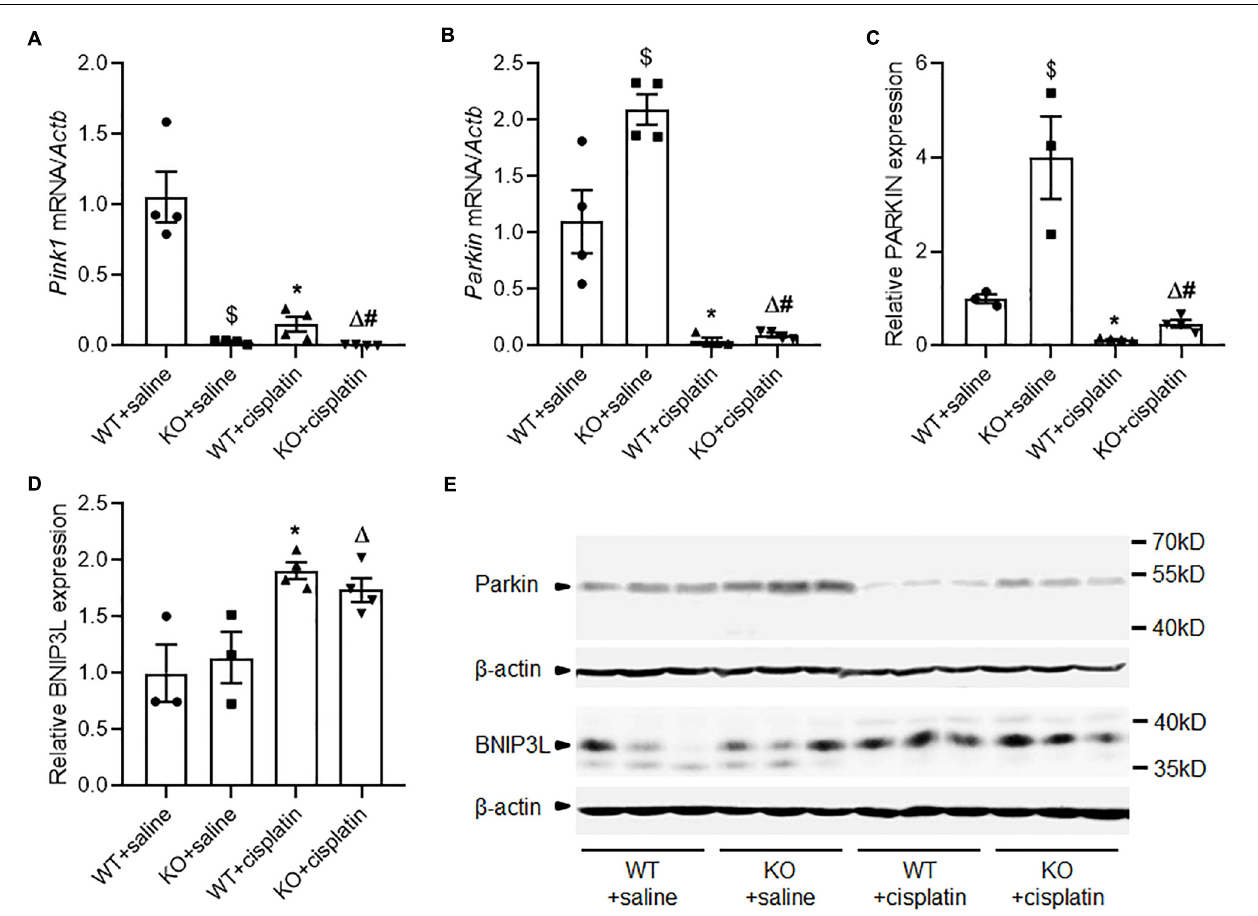
FIGURE 3 | Altered expression of PINK1, Parkin and BNIP3L during cisplatin treatment in PINK1 WT and KO rats. (A) Real-time quantitative PCR analysis of Pink1 mRNA expression in renal cortex. (B) Real-time quantitative PCR analysis of Parkin mRNA expression in renal cortex. (C) Quantitative analysis of the western blotting of Parkin. (D) Quantitative analysis of the western blotting of BNIP3L. (E) Representative western blot bands of Parkin and BNIP3L in renal cortex. N = 3 in WT + saline group and KO + saline group, N = 4 in WT + cisplatin group and KO + cisplatin group. ∗ P < 0.05, WT + cisplatin vs. WT + saline; # P < 0.05, KO + cisplatin vs. WT + cisplatin; (cid:49) P < 0.05, KO + cisplatin vs. KO + saline; $ P < 0.05, KO + saline vs. WT + saline. Data are mean ±